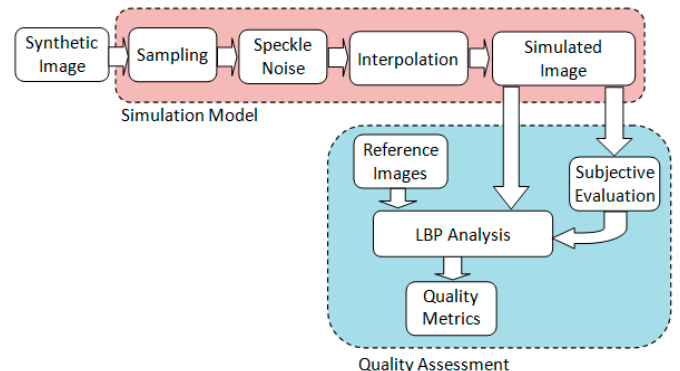
Figure 3. The simulation and evaluation stages of the processing pipeline.